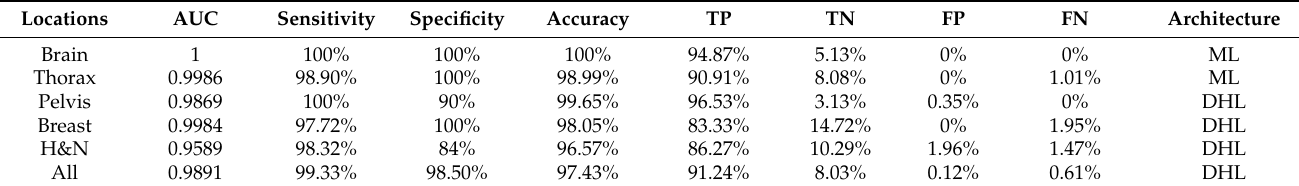
Table 4. AI models architecture and performance for each tumor